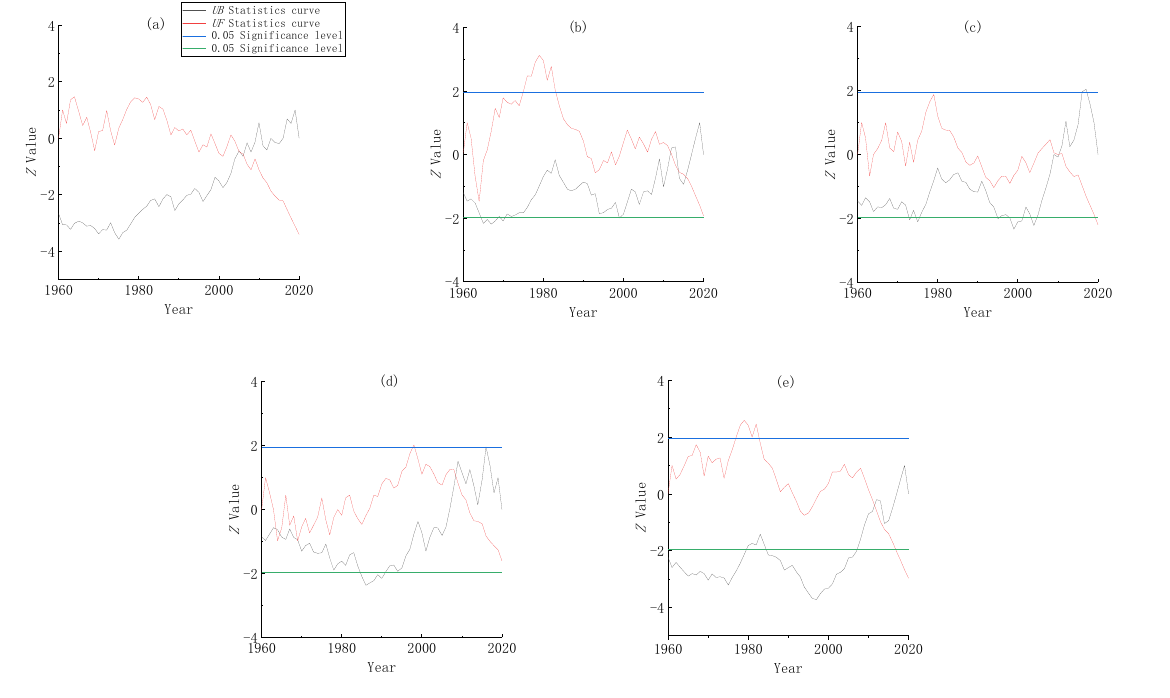
Figure 5. Mann–Kendall (MK) analysis of ET 0 in ( a ) spring, ( b ) summer, ( c ) autumn, ( d ) winter and ( e ) inter-annually from 1960 to 2019.